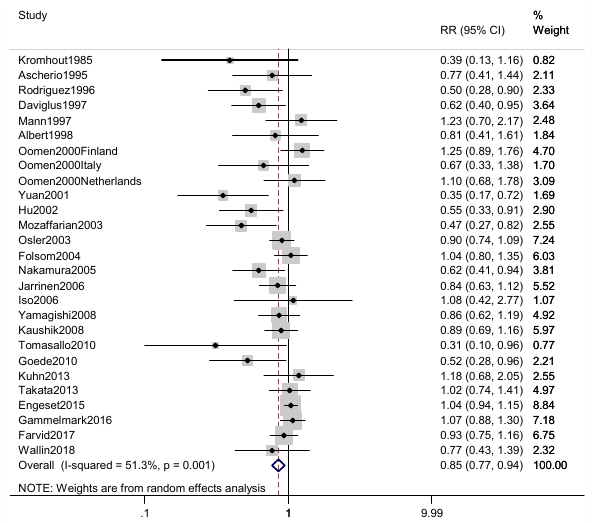
Figure 3. Forest plot of fish consumption with risk of CHD death. The pooled effect was calculated by using a random-effects model. The diamonds denote summary risk estimate, and horizontal lines represent 95% CI. Abbreviations: RR, relative risk; CI, Confidence interval.